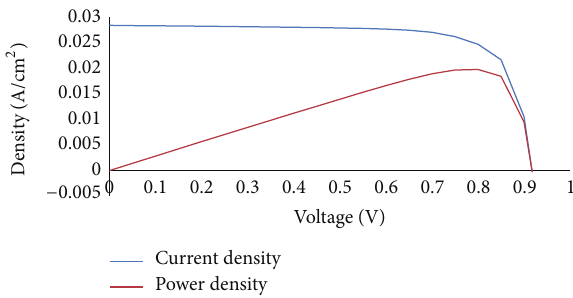
Figure 10: Optimized CdS/CdTe cell with 𝑉 28.45 mA/cm 2 , and an efficiency of